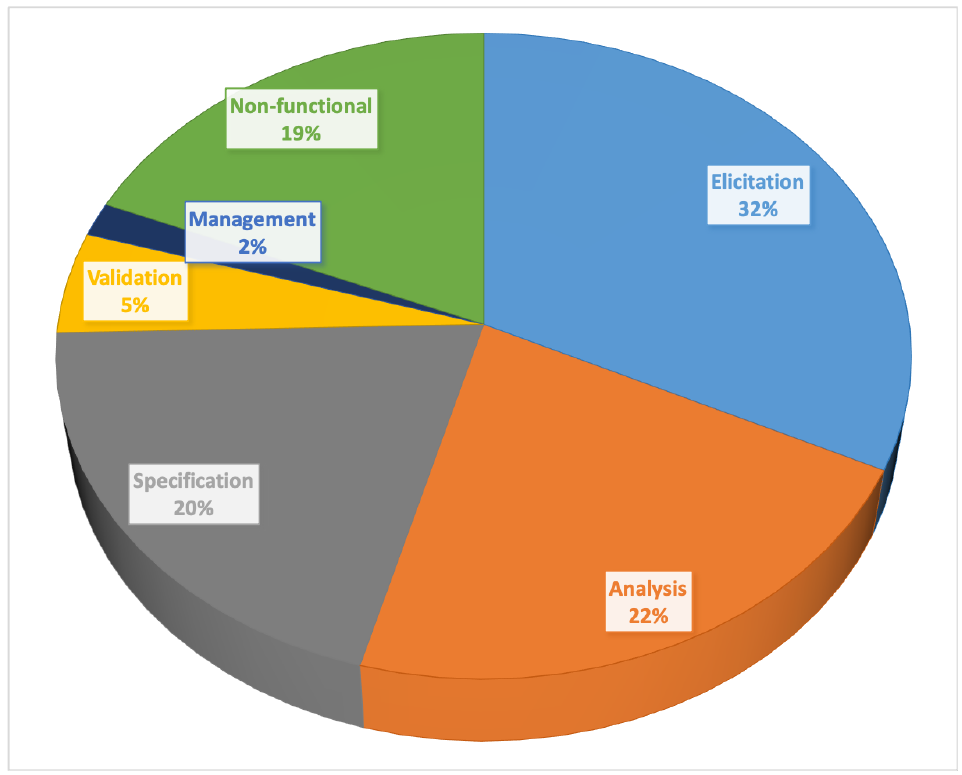
Figure 1. Classification scheme of primary studies according to the RE activities introduced in Section